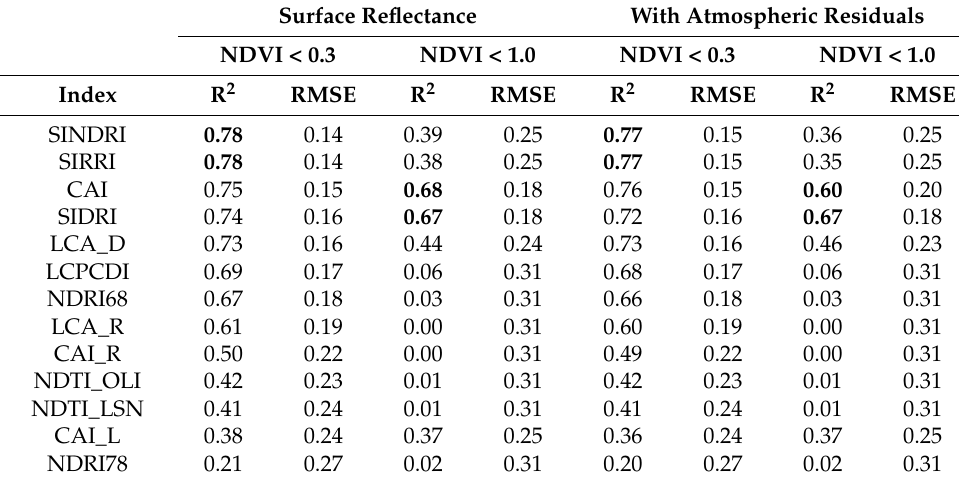
Table 3. Shortwave infrared (SWIR) index performance measures (R 2 , RMSE) for prediction of fractional non-photosynthetic vegetation (NPV) cover, for gaussian surface reflectance spectra and for gaussian spectra modified to simulate residual artifacts of atmospheric calibration, and sensor noise. Indices were derived from gaussian spectra using 30 nm bandwidth in all bands. Surface Reflectance With Atmospheric Residuals NDVI < 0.3 NDVI <